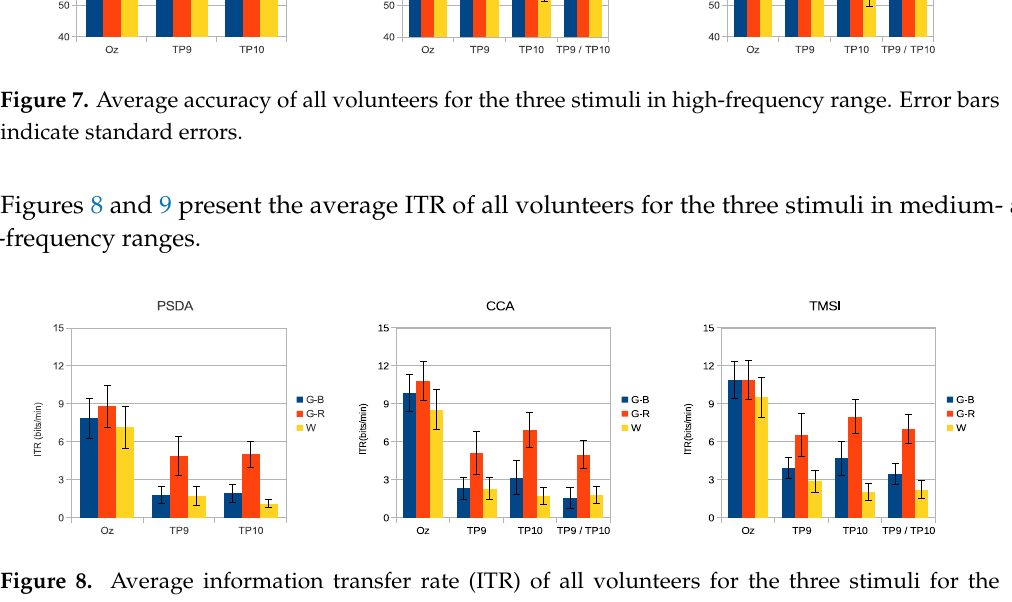
Figure 8. Average information transfer rate (ITR) of all volunteers for the three stimuli for the medium-frequency range. Error bars indicate standard errors.